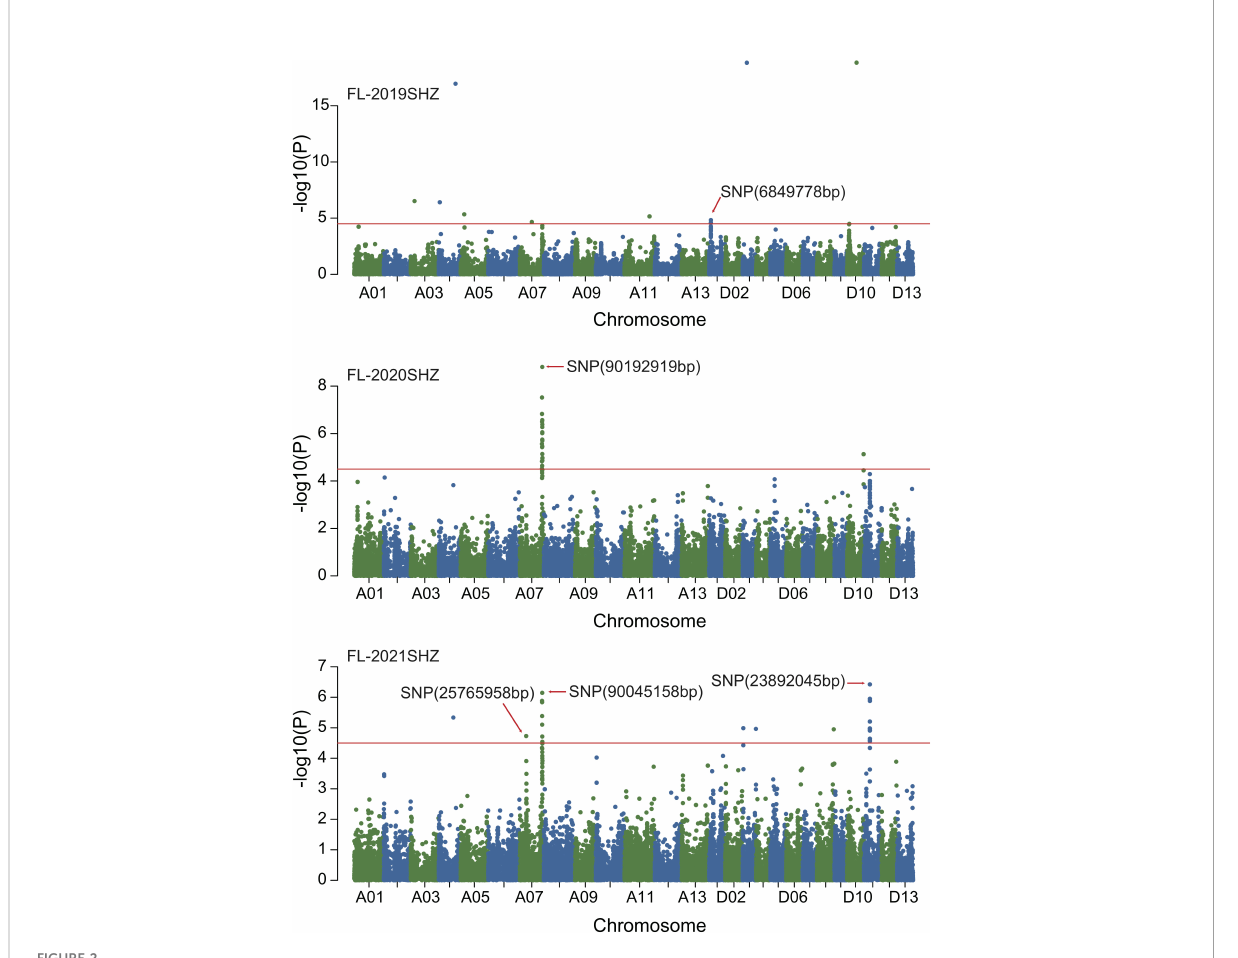
FIGURE 2 Manhattan of genome-wide association studies for fi ber length in Shihezi. FL-2019SHZ: Fiber length in the Shihezi environment in 2019; FL- 2020SHZ: Fiber length in the Shihezi environment in 2020; FL-2021SHZ: Fiber length in the Shihezi environment in